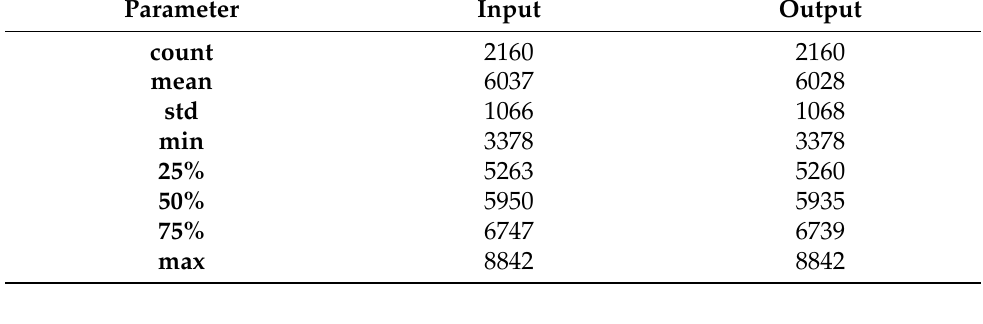
Table 2. SLR: statistical information of active power load dataset.